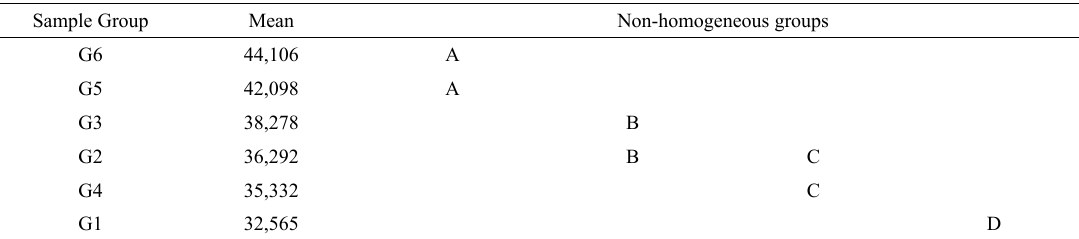
Table 1. Sample x mean x non-homogeneous groups Sample